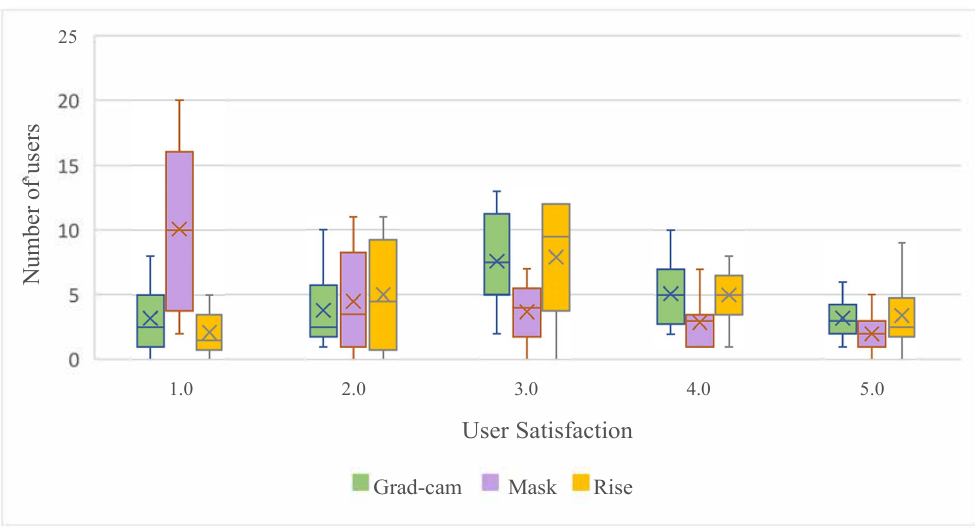
Figure 13. The user satisfaction distribution of different interpretation algorithms under the top-3% occlusion. Each interpretation method is tested with 10 images from DataS and 35 users. Satisfaction score is 1–5 (1 means most dissatisfied, 5 means most